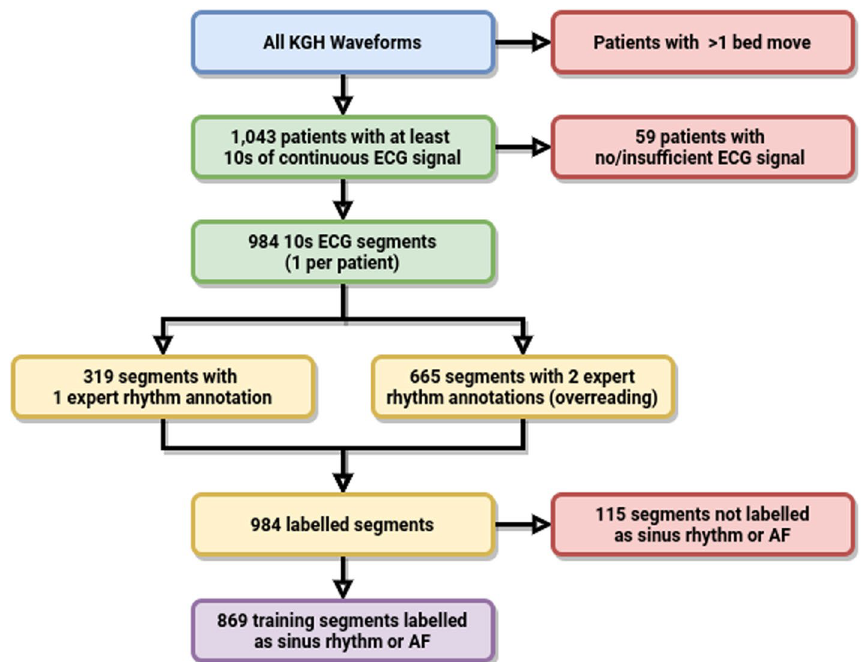
Fig. 2 Flowchart for the patient cohort selection and data annotation